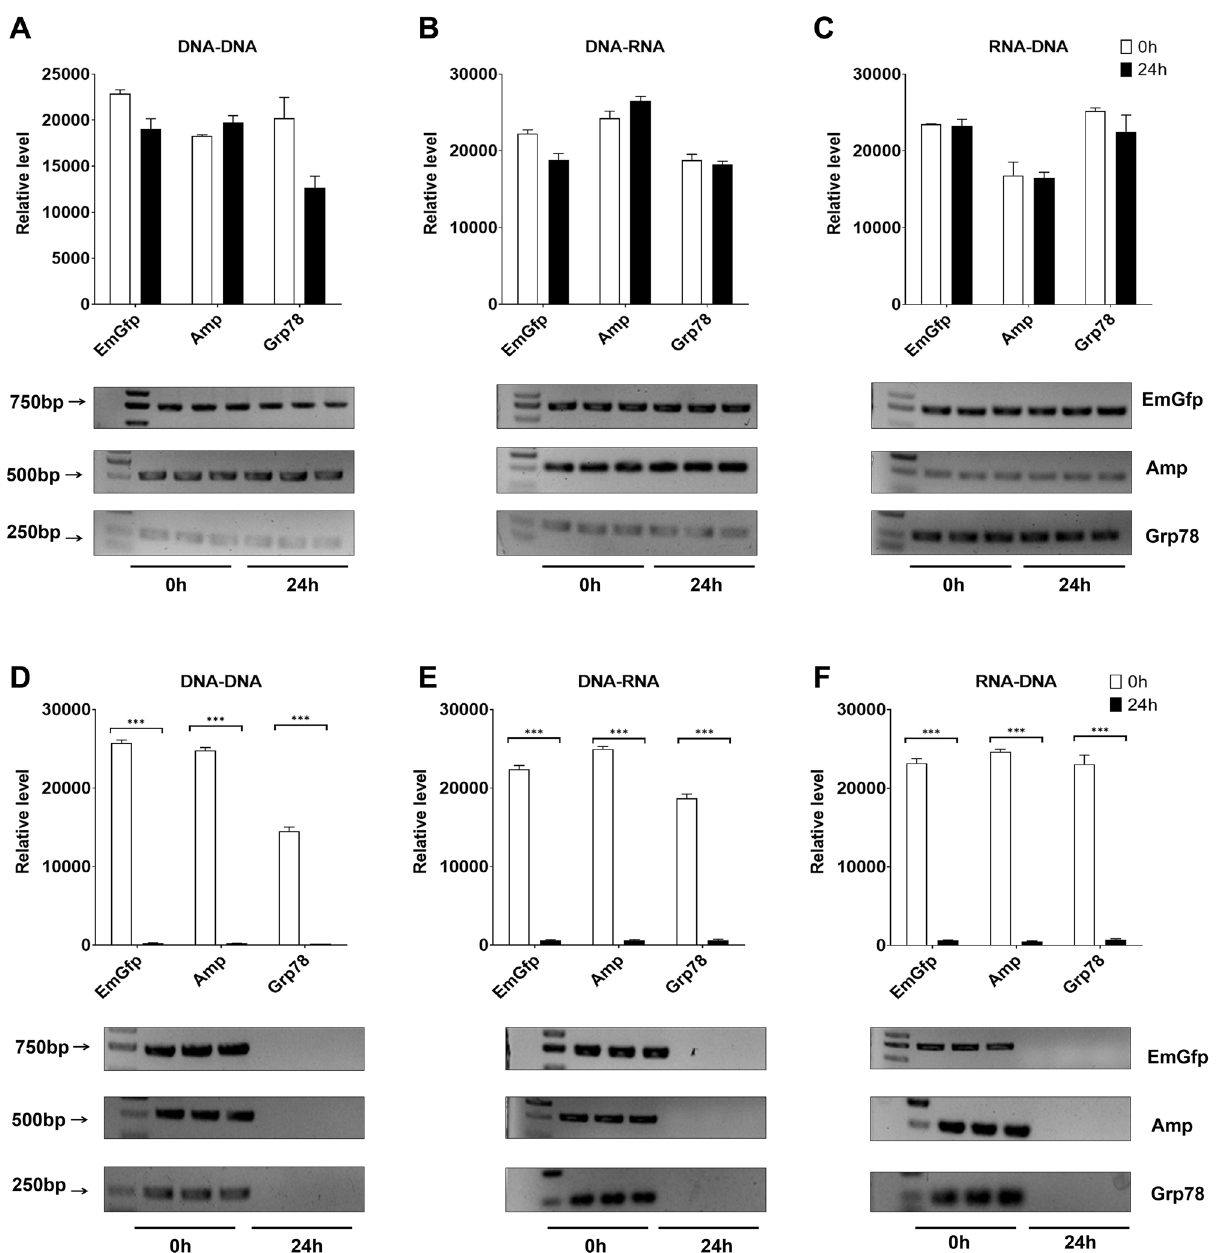
Figure 3. After coculture of HepG2 cells with lysozyme for 24 h, the cell lysate and supernatant of HepG2 cells showed different effects on the PCR process in vitro. ( A )–( F ) Gel electrophoresis of PCR products. The supernatant ( A )–( C ) and cell lysate ( D )–( F ) of HepG2 cells were added to the reaction system: ( A / D ) replication, ( B / E ) transcription and ( C / F ) reverse transcription. Intensity analysis of target bands in gel electrophoresis results shown to the top of the blot. Data are representative of 2 independent experiments and presented as the mean ± SD; * p < 0.05, *** p < 0.001. Significant differences were evaluated using one-way ANOVA with a post hoc test (Fisher’s least significant